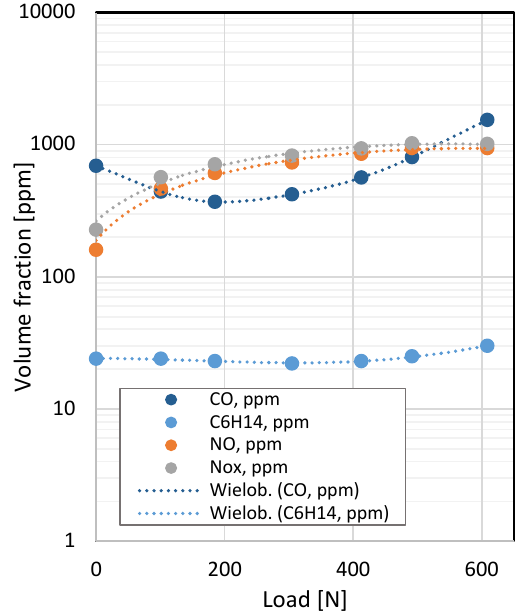
Fig. 12. Exhaust gases composition as a function of engine load during operation in 1700 rpm